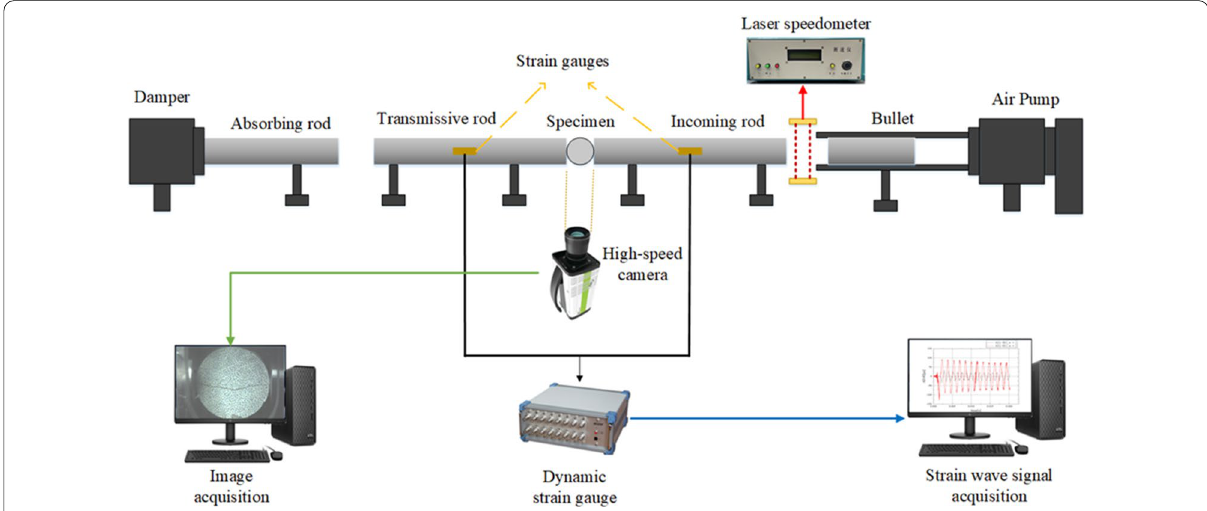
Fig. 1 Schematic diagram of the dynamic splitting test system.